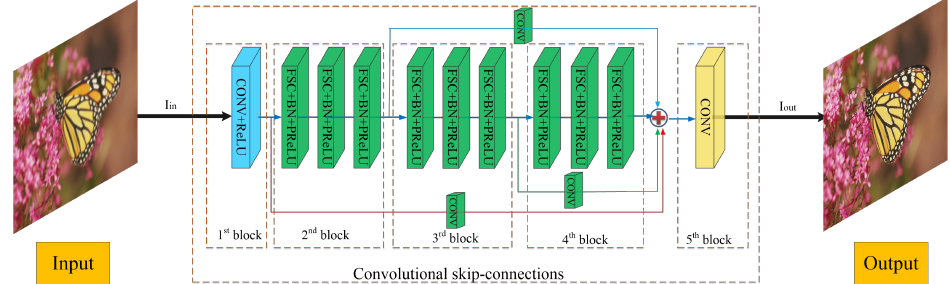
Figure 3. The convolutional skip-connections for our parallel architecture, with 5 blocks in the network. The 1st block can extract some coarse features, and 3 convolutional skip-connections (from the 2nd to the 4th blocks) are used to carry semantic information for the generated images. The last convolutional layer generates the synthesized images in the 5th